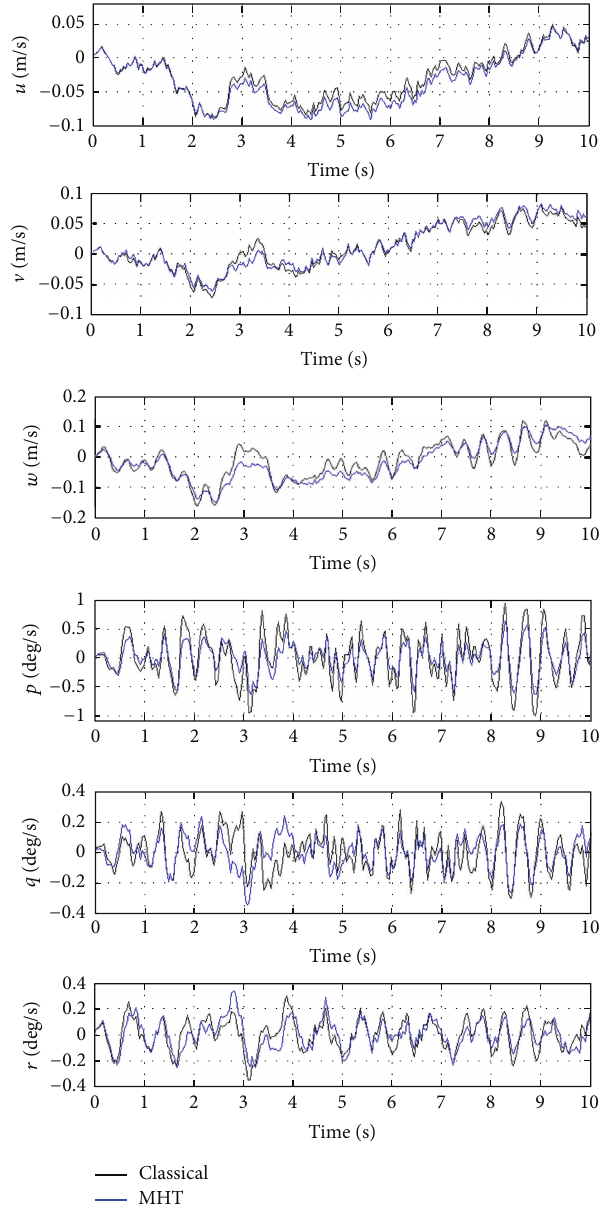
Figure 6: Responses of helicopter linear and angular velocity states.